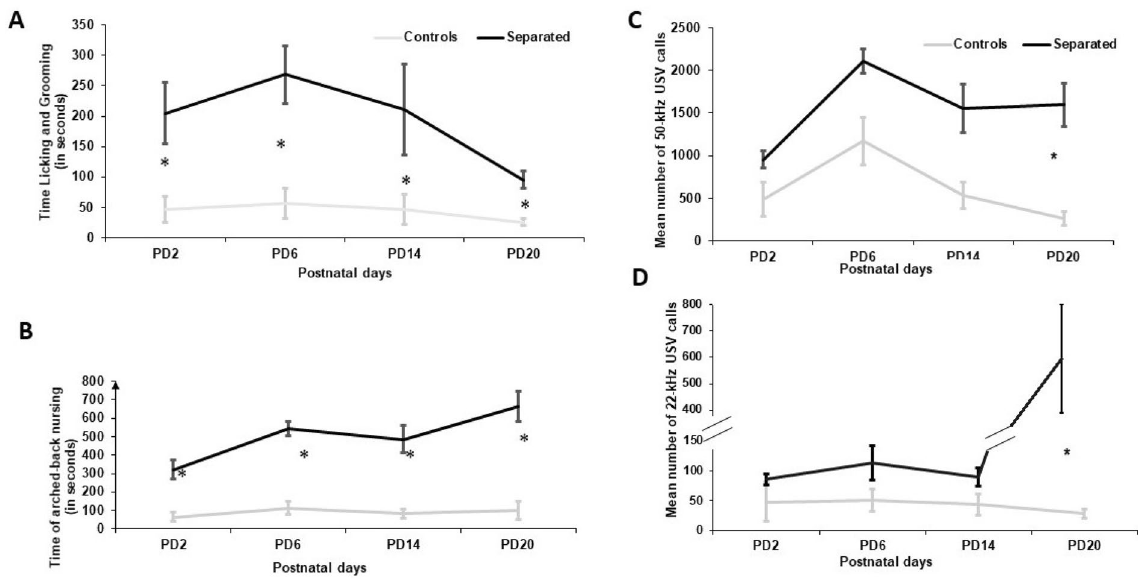
Figure 1. Licking and grooming ( A ) and arched-back nursing ( B ) behavior at PD2, PD6, PD14, and PD20 in separated (black) and unseparated (grey) dams. Separated dams were expressing significantly higher licking and grooming behavior. Amount of 50-kHz ( C ) and 22-kHz ( D ) frequencies calls: Separated dams (black) vocalized significantly more at 50-kHz and 22-kHz frequencies at the last day measured compared to control dams (grey). Mean number of 50-kHz and 22-kHz USV calls ± SEM are presented for n = 8 controls and n = 8 separated dams. Data were analyzed by student’s